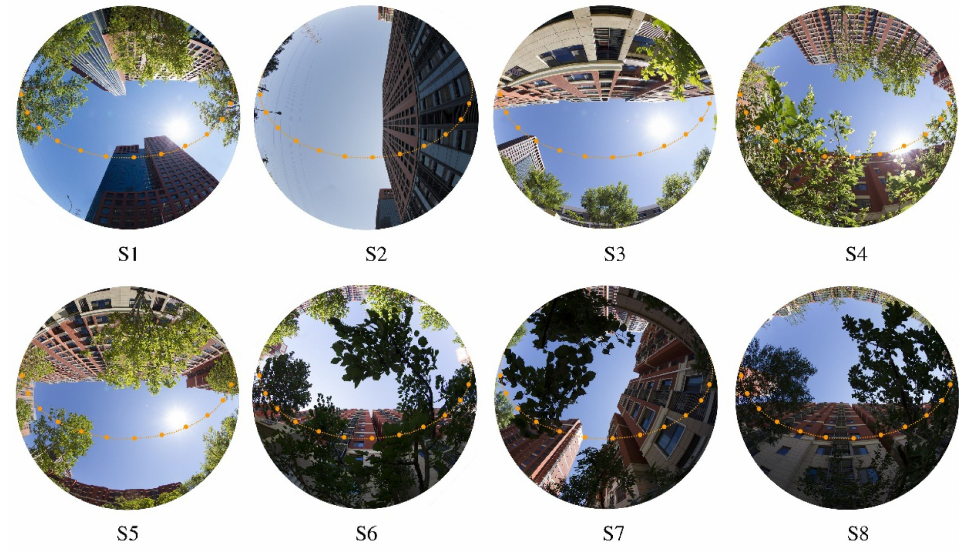
Figure 12. Fisheye photos of eight observation points in Shuangqing Estate. From 15:00 to 18:00, S4, S6 and S8 were shaded by both buildings and trees. S1 was shaded by trees. S2, S3, S5, and S7 were unshaded. The average temperature of the and the average temperature of the observation points without shading was about 33.1 ◦